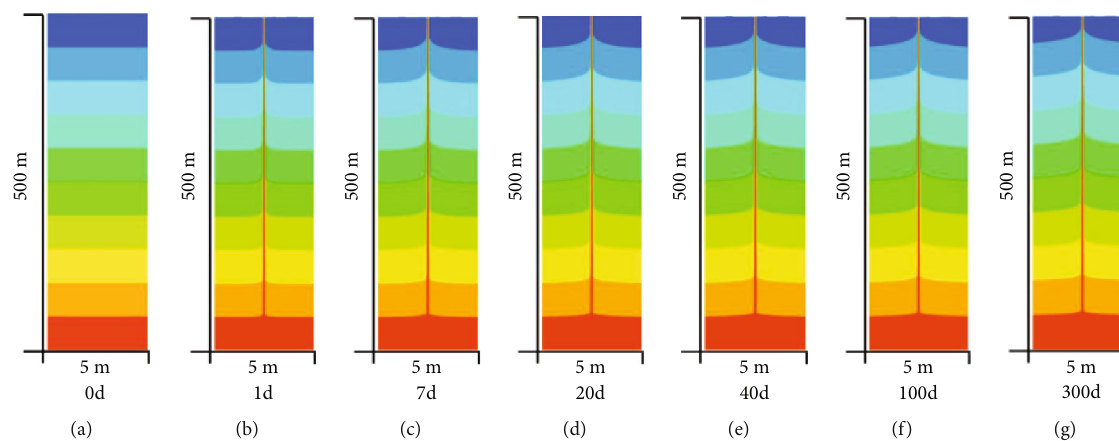
Figure 5: Temperature distribution at di ff erent times during production.